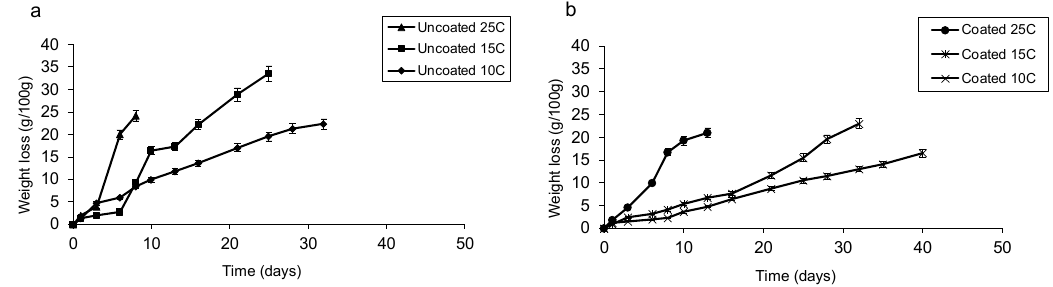
Figure 4. Weight loss in ( a ) uncoated control and ( b ) coated limes during storage at different temperatures. Table 2. Kinetic parameters for weight loss of coated and uncoated limes stored at different temperatures.